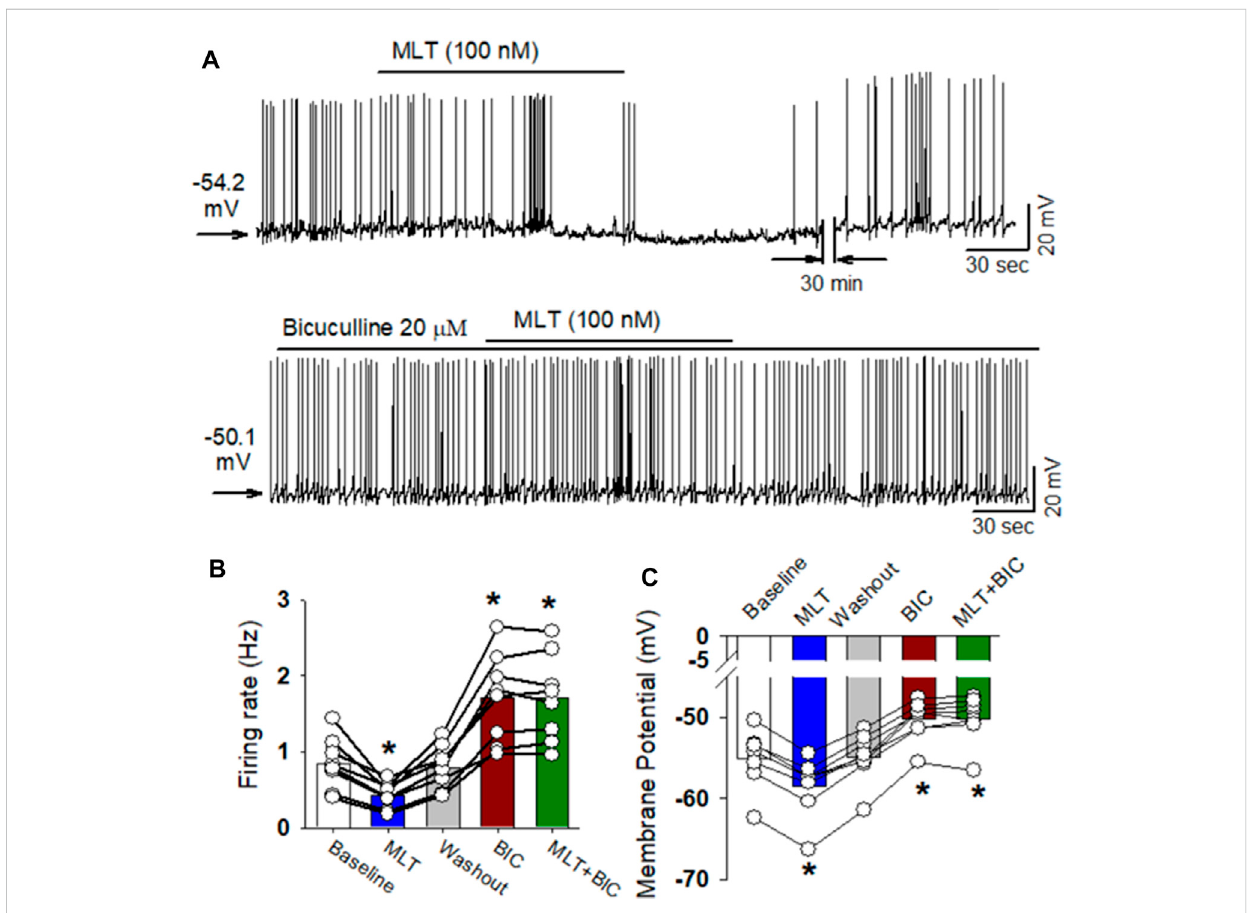
GABAA receptor antagonist eliminated melatonin-induced decrease in fi ring activity of RVLM projecting PVN neurons. (A) , Representative raw tracings showing the spontaneous fi ring activity during application of 100 nM melatonin, 20 μ M bicuculline, bicuculline plus melatonin. Please note that application of bicuculline signi fi cantly increased the fi ring activity of RVLM projecting PVN neurons. Furthermore, bicuculline eliminated the effect of melatonin on the fi ring activity and membrane potentials. (B,C) , summary data of fi ring rate (B) and membrane potentials (C) showing that GABA A receptor antagonist bicuculline eliminated melatonin-induced decrease in fi ring activity and hyperonization of RVLM projecting PVN neurons. Please note that bicuculline increased the fi ring activity and depolarized the membrane potentials of RVLM projecting PVN neurons. Data are presented as means ± SEM (* p < 0.05 compared with the control; ANOVA, followed by Dunn ’ s post hoc test). MLT,